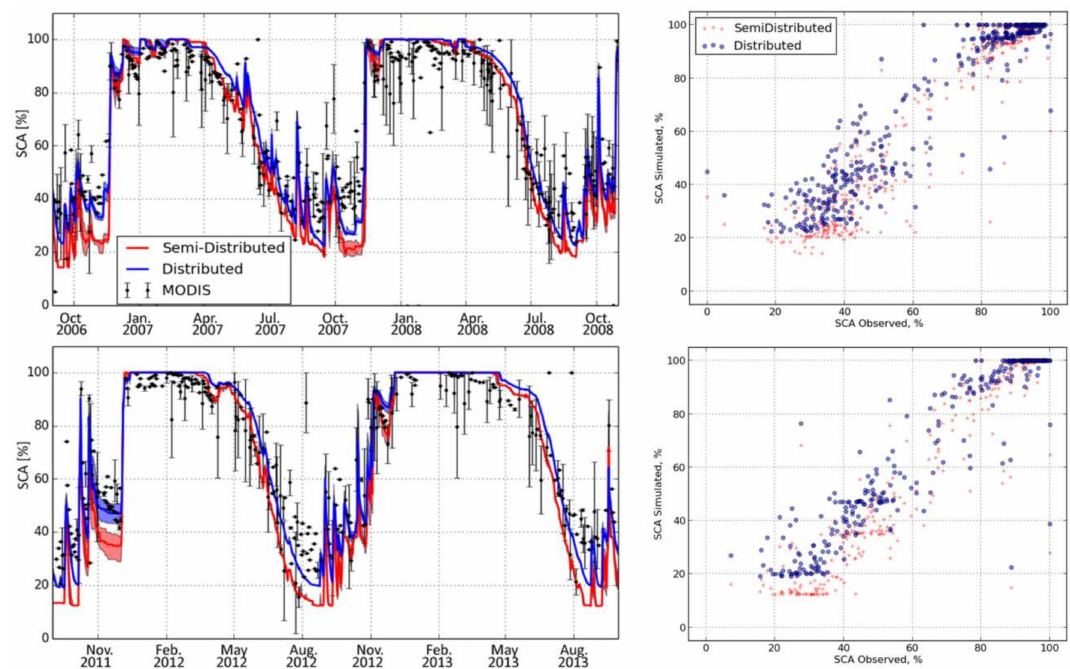
Figure 7. ( Left ) Observed and simulated SCA evolution for a period of low level snowpack accumulation (2006–2008; upper panel) and a period of high level snowpack accumulation (2011–2013 lower panel). The vertical bars for the MODIS observations show the uncertainty associated with cloud presence for days having ≤ 20% snow cover. Red and blue shading for the distributed and semi-distributed SCA simulations show the uncertainty associated with various snow depth thresholds for determining whether a pixel was snow covered. The lower limit of the shading represents the SCA evolution for a 0.1 m threshold, the upper limit of the shading represents a 0.2 m snow depth threshold, and the middle line represents a 0.15 m snow depth threshold. ( Right ) Scatter plot between observed ( X axis) and simulated ( Y axis) SCA obtained with semi-distributed and distributed approaches for same time period of the left graphs (respectively 2006–2008 and